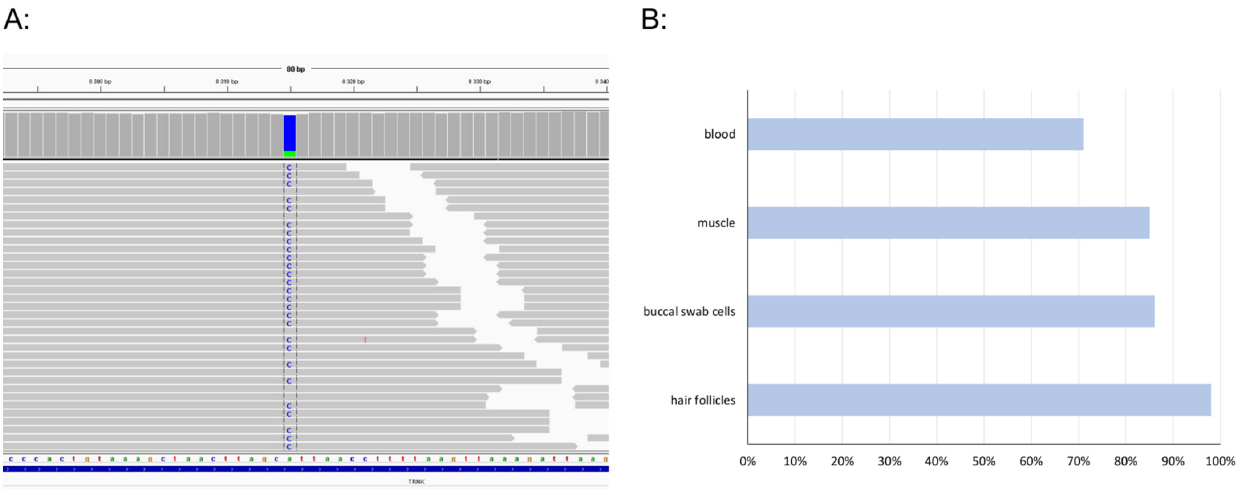
Figure 1. A MTTK gene variant m.8315A>C. IGV snapshot of mtDNA sequencing in patient’s muscle ( A ); overview of heteroplasmy levels in patient tissues ( B ).